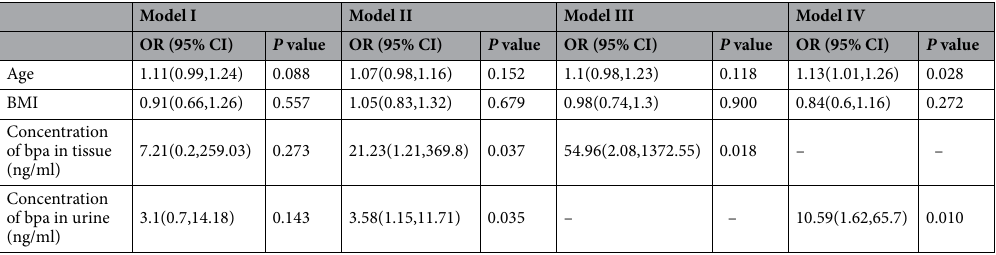
Table 5. The effects of the different variables on the breast cancer. OR: odds ratio; CI: Credible interval.